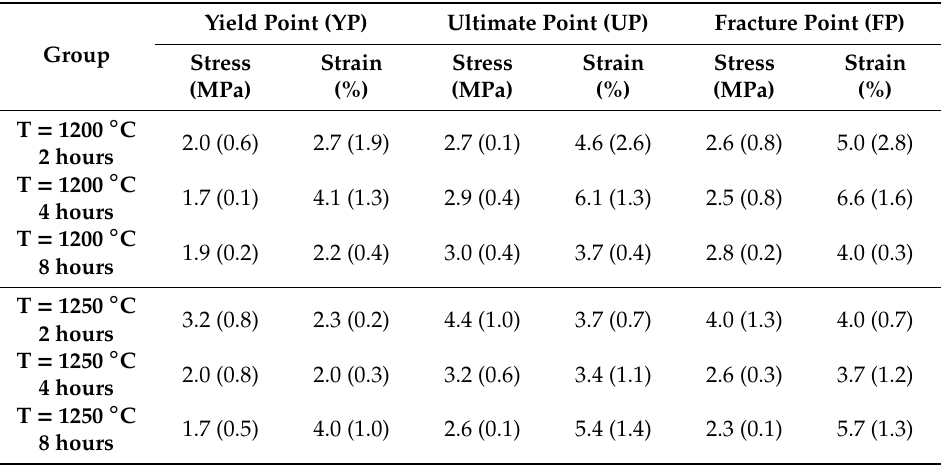
Table 1. Compressive Tests. Mean (std.dev) are